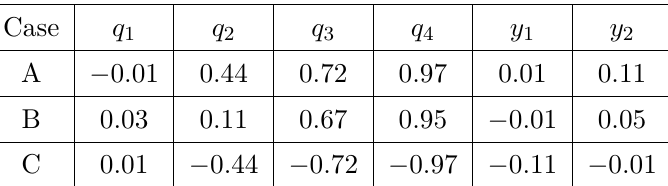
Table 1 . Values of the parameters q I , and corresponding roots y 1 , 2 , for which the three cases are